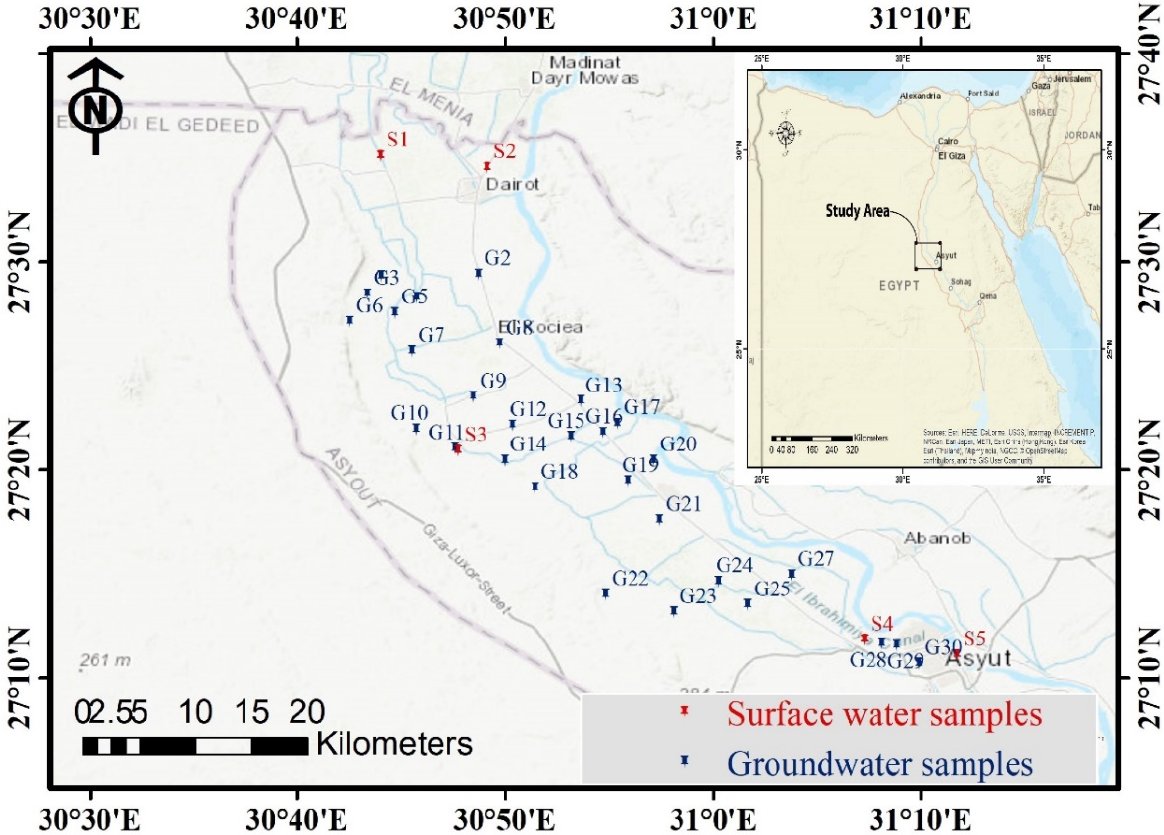
Figure 1. Location map of the study area.